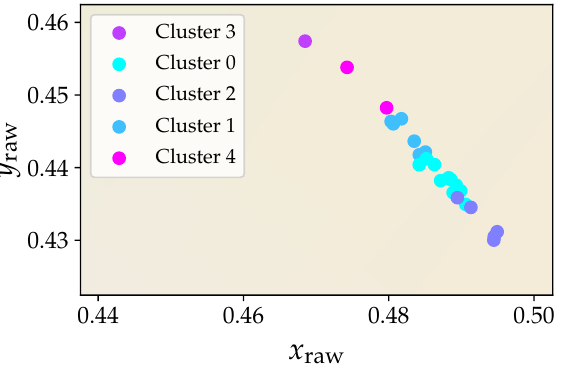
Figure 3. Classification of the color sensors into five bins of similar behavior in response to a warm white, phospor-converted LED spectrum. An agglomerative cluster algorithm has been applied for proper sensor assignment.